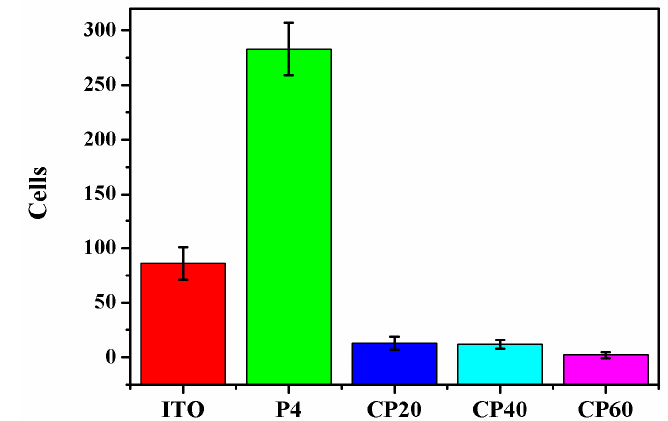
Figure 8. Quantification of cells appearing on different sample surfaces, data are shown as mean ± standard error for three samples.